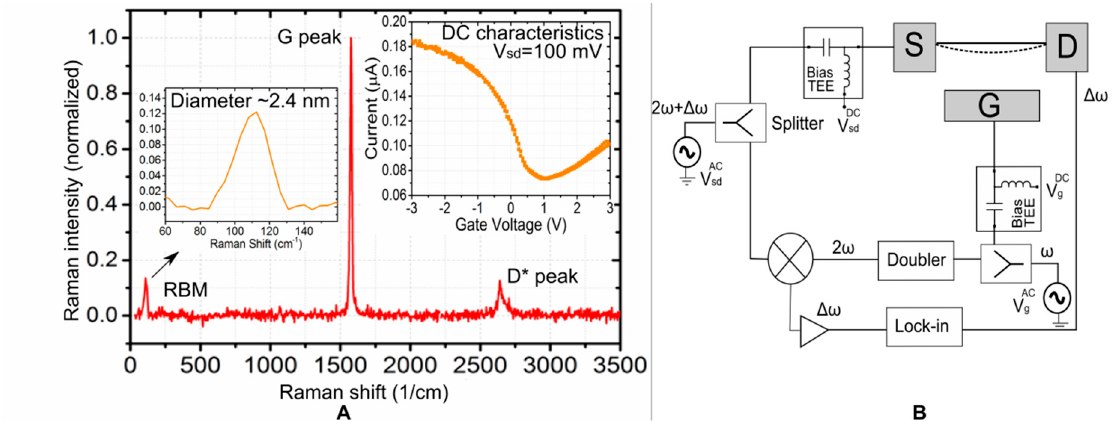
Figure A1. ( A ) CNT characteristics obtained from Raman spectroscopy and DC measurement. ( B ) Experimental Setup for measuring the piezoresistive